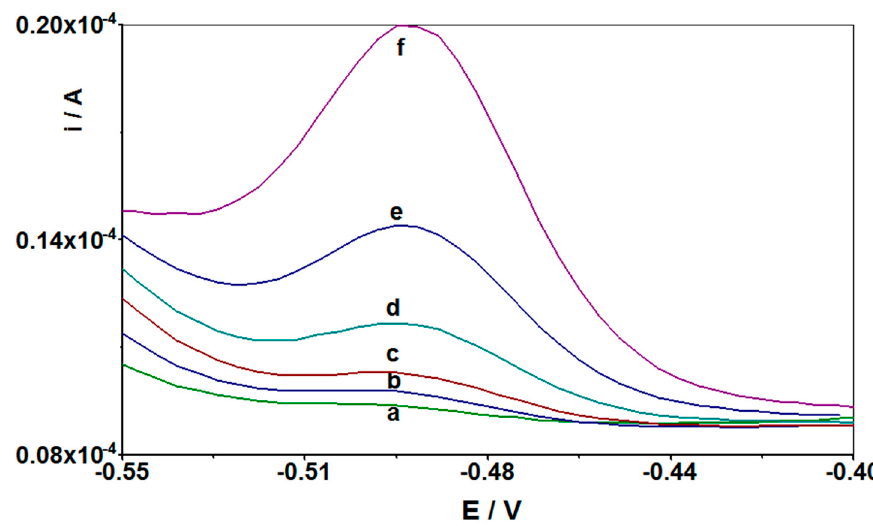
Figure 5. Differential pulse voltammograms obtained in the course of Cd(II) determination at the GCE working electrode recorded for solutions containing: ( a ) background: 1 mL 1 M HCL + 125 µ L 1 g/L Cu(II) and distilled water; ( b ) as ( a ) + 1 × 10 − 9 Cd(II); ( c ) as ( a ) +2.5 × 10 − 9 Cd(II); ( d ) as ( a ) + 5 × 10 − 9 Cd(II); ( e ) as ( a ) + 1 × 10 − 8 Cd(II); and ( f ) as ( a ) + 2.5 × 10 − 8 Cd(II). Accumulation potential − 0.7 V and accumulation time 210